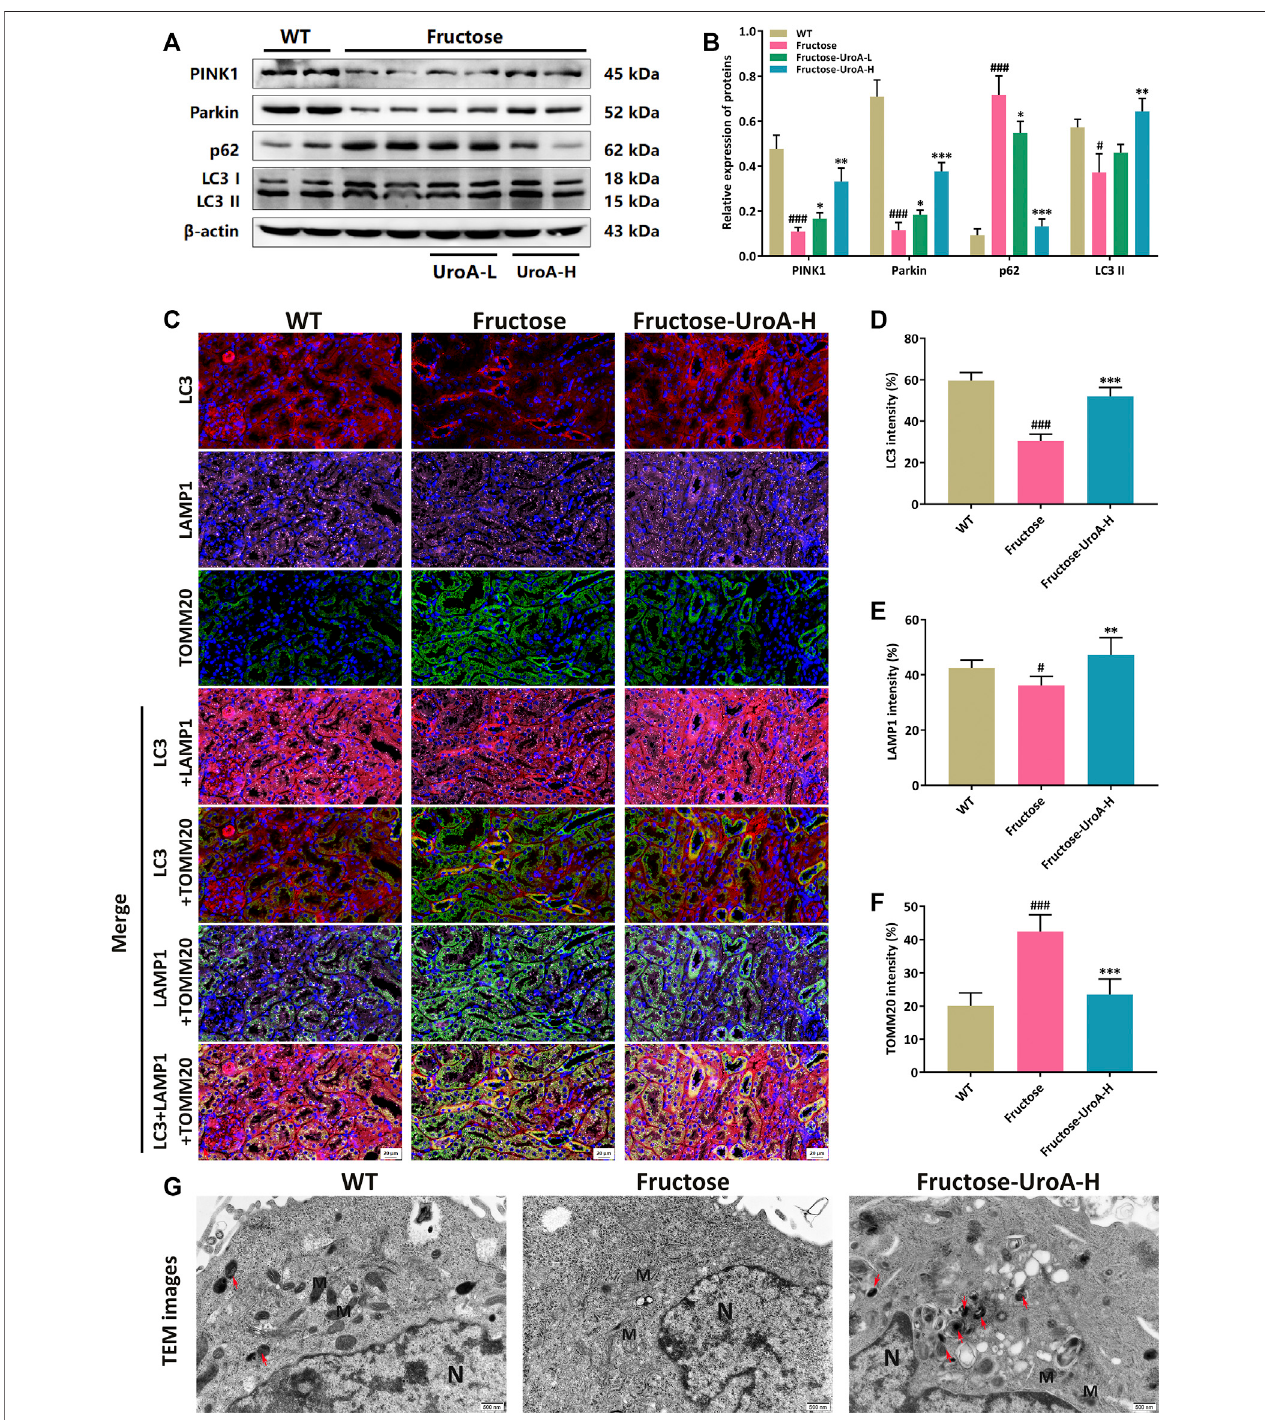
FIGURE 4 | Urolithin A (UroA) promotes renal PINK1/Parkin-mediated mitophagy in fructose-fed mice. (A,B) Representative immunoblots of PINK1, Parkin, p62, and LC3 I/II protein levels in mouse kidneys (A) and densitometric analysis (B) . β -actin was used as an internal reference. (C) Representative images of immuno fl uorescencestainingofLC3,LAMP1,andTOMM20ofkidneytissuesections(Red,LC3;Purple,LAMP1;Green,TOMM20). Originalmagni fi cation:×400;Scale bar: 20 μ m. (D – F) Densitometric analysis of LC3 (D) , LAMP1 (E) , and TOMM20 (F) . (G) Representative transmission electron microscopy (TEM) images in the kidney tissues from the wild-type (WT) or fructose-fed mice with intragastric administration of either vehicle or UroA, respectively. N: nucleus; M: mitochondria; autolysosomes (red arrow). Mean ± S.D., n = 5. # p < 0.05, ### p < 0.001 versus the WT group; * p < 0.05, ** p < 0.01, *** p < 0.001 versus the fructose group. UroA-L and UroA-H represent intragastric administration of urolithin A at low (50 mg/kg/day) and high (100 mg/kg/day) doses, respectively.